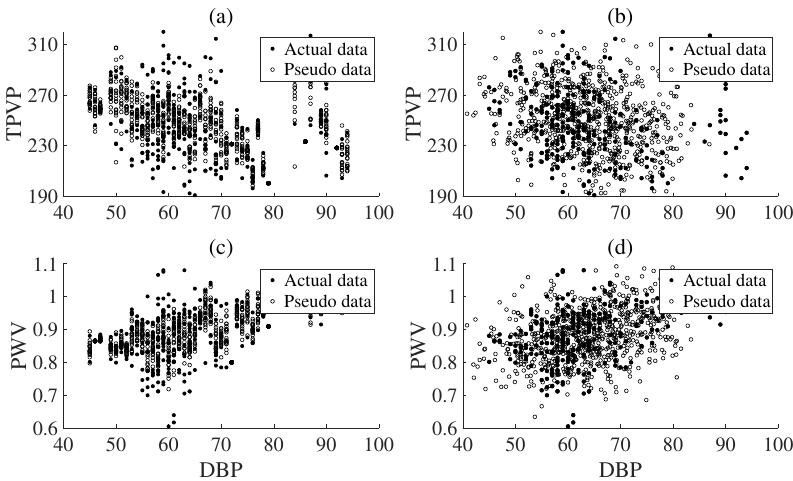
Figure 6. Data augmentation results for TPVP, PWV and reference DBP (unit: mmHg). ( a , c ): the bootstrap algorithm, ( b , d ): the proposed algorithm. Table 2. Experimental results (unit: mmHg) of the proposed algorithm and bootstrap algorithm for estimating the BP using the first NN. Abbreviations; data augmentation (DA), standard deviation of error (SDE), confidence interval